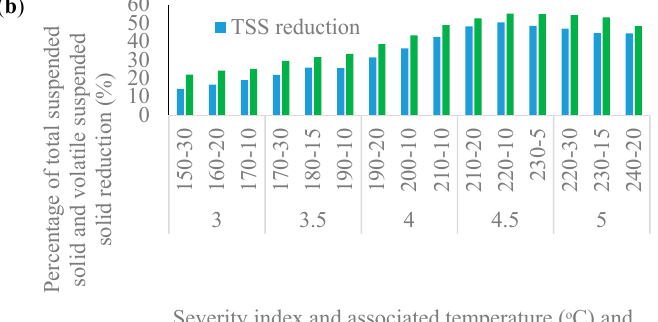
Figure 2. The effect of HTP on solid reduction; ( a ) Solid concentration before and after HTP; ( b ) solid reduction percentage of the SSO samples after and before HTP.